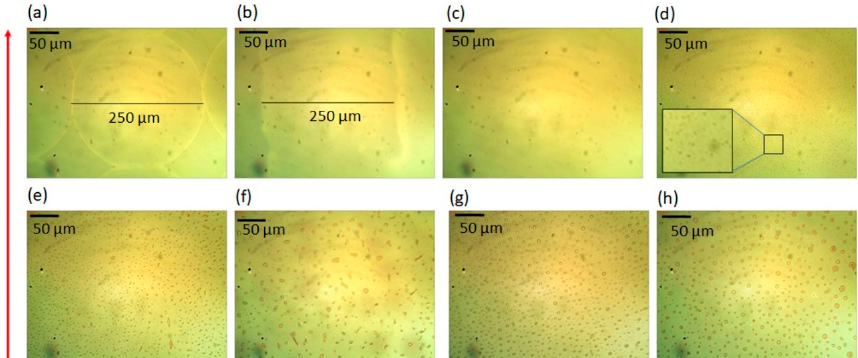
Figure 3. Optical images of Cs 2 CO 3 films printed using ink with 2 mg/mL concentration with resolutions: ( a ) 100 dpi ( b ) 200 dpi ( c ) 300 dpi ( d ) 400 dpi (e) 500 dpi ( f ) 600 dpi ( g ) 700 dpi and ( h ) 800 dpi. Red arrow on the left side shows the printing direction (vertically up).